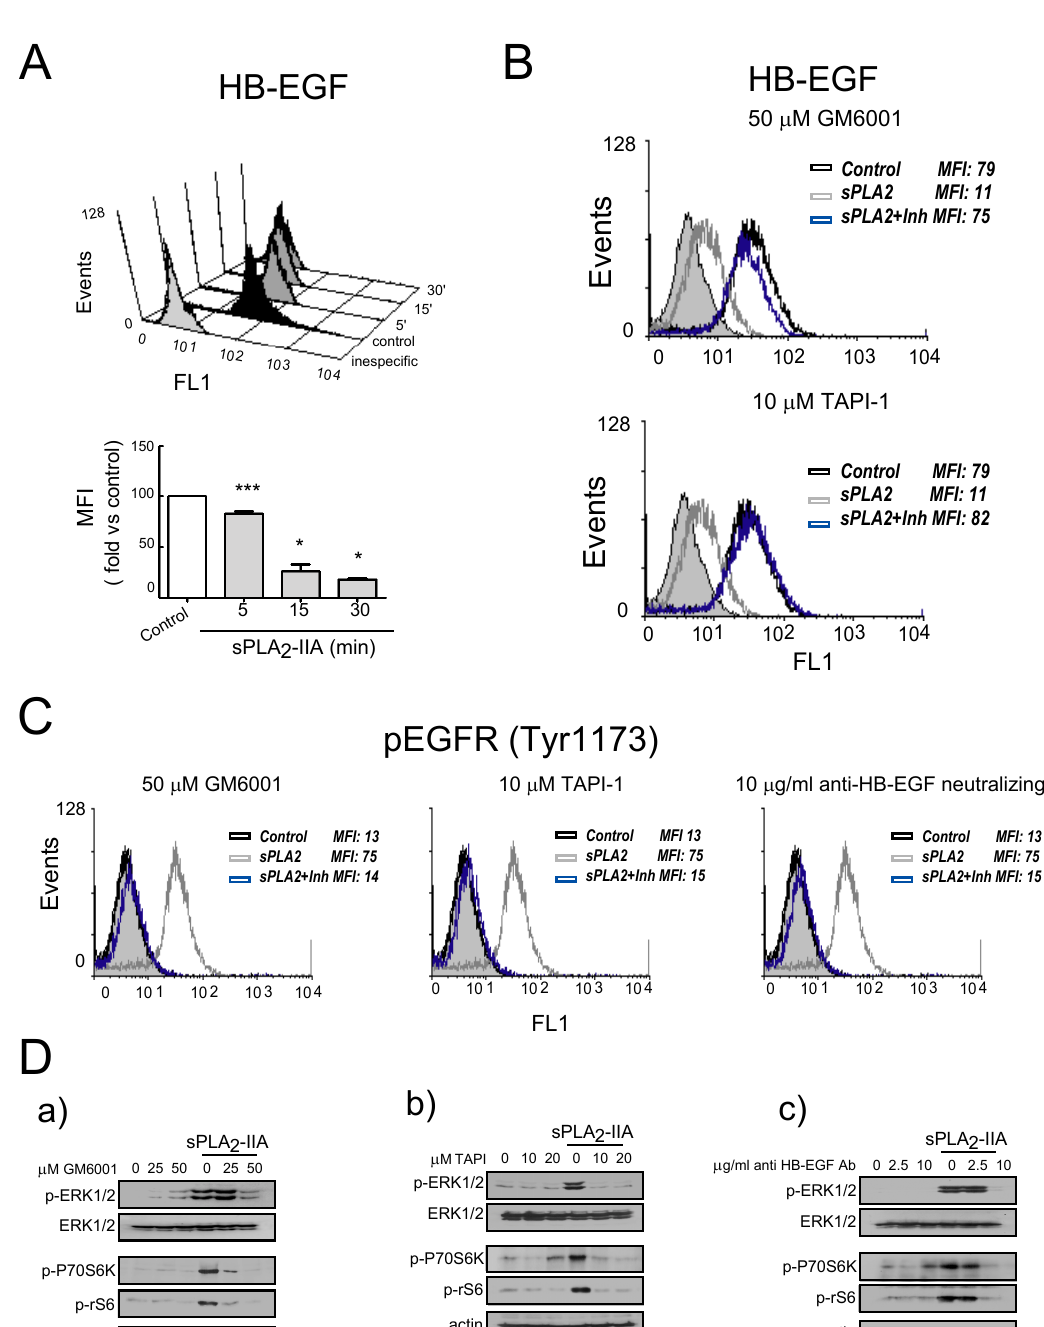
Figure 5. sPLA 2 -IIA-activated intracellular signaling cascades in cardiac fibroblasts (CFs) require HB-EGF shedding. ( A ) Cells were stimulated with 1 μg/mL of sPLA 2 -IIA for the indicated times, and HB-EGF expression was determined by flow cytometry: untreated (solid black curves) and sPLA 2 -IIA-treated (solid dark grey curves) CFs were compared with isotype controls (solid light grey curves). * p < 0.001, ** p < 0.01, and *** p < 0.5 vs. control cells; mean ± SD CFs were pretreated with the indicated inhibitors and then incubated with 1 µ g / mL of sPLA 2 -IIA: after 15 min, HB-EGF ( B ) and phospho-EGFR ( C ) expression were analysed by flow cytometry: untreated cells (open black curves) were compared with sPLA 2 -IIA-treated cells in the absence (open dark grey curves) or presence of the indicated inhibitors (open blue curves). Solid light grey curves show isotype controls. ( D ) After 15 min, ERK, Akt, P70S6 and S6 phosphorylation were determined by immunoblotting. n = 3.